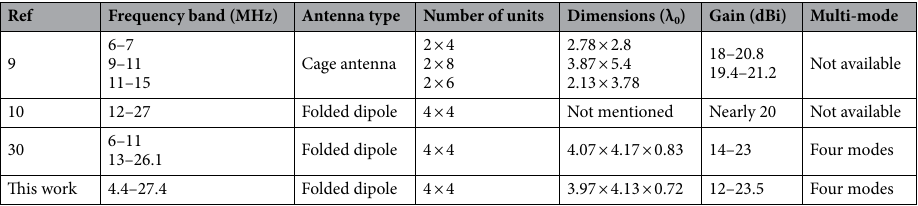
Table 2. Comparison between existing SW broadcast arrays and proposed